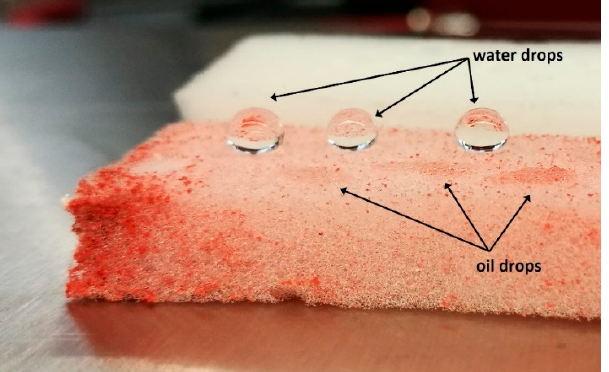
Figure 12. Water drops and absorbed oil drops on superhydrophobic filter.